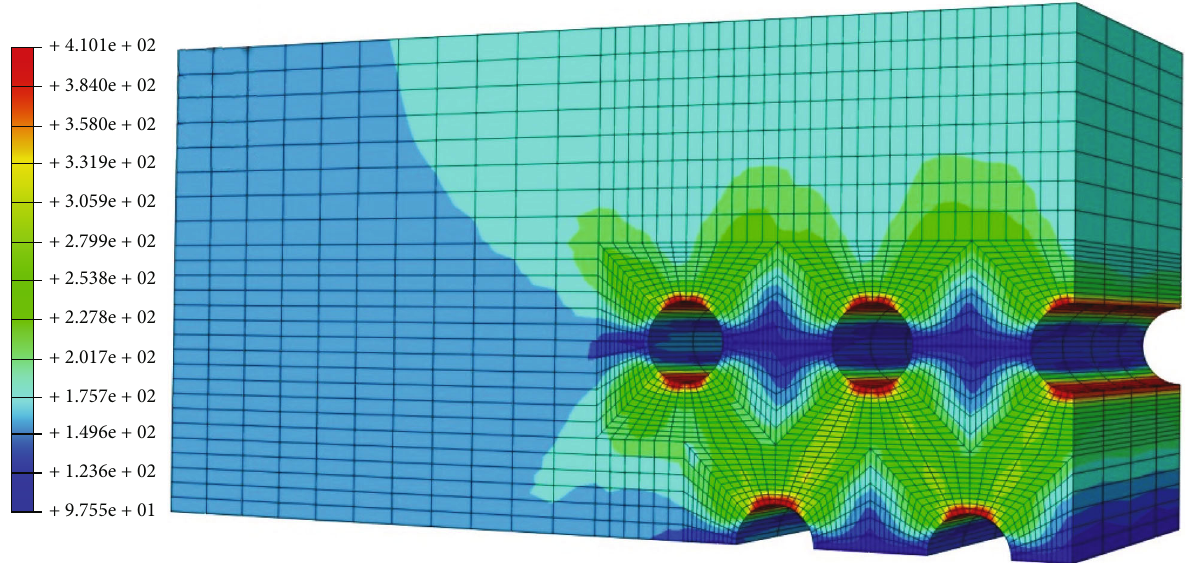
Figure 7: Maximum principal shear stress distribution multihole specimen (unit: MPa).